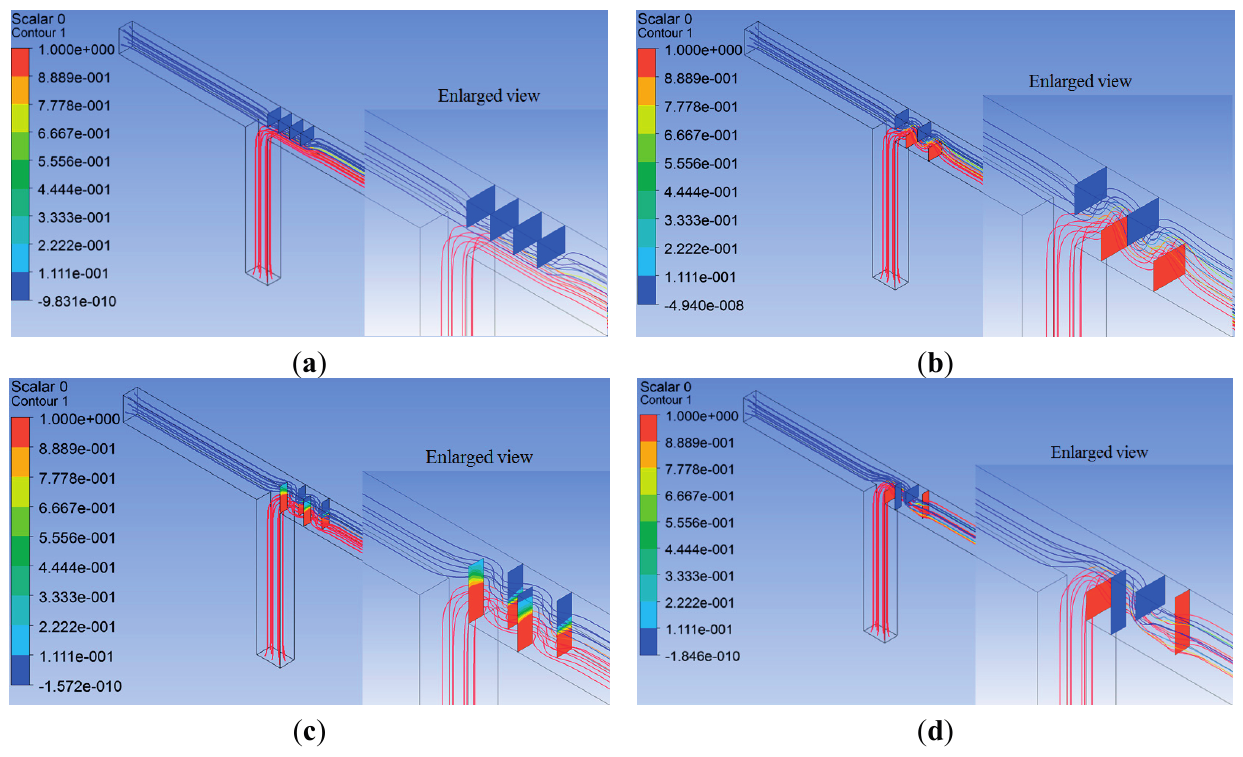
Figure 6. Comparison of the streamline patterns and vorticity distributions around the baffles. ( a ) Upper wall attachment. ( b ) Opposite wall attachment: type 1. ( c ) Opposite wall attachment: type 2. ( d ) Cyclic